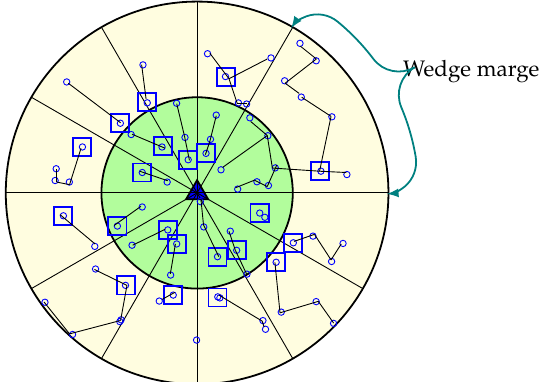
Figure 10. Occurrence of first wedge merge with a new chain formation and Header Node (HN) selection.